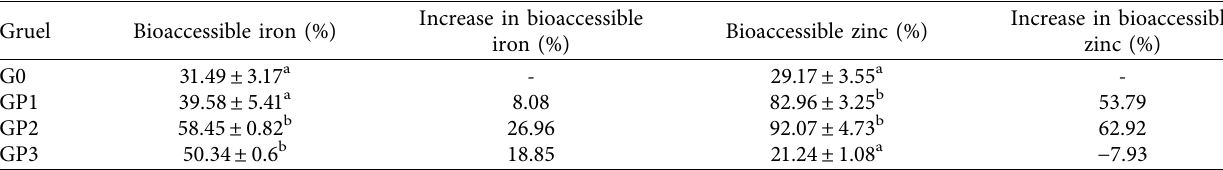
Table 5: Bioaccessibility of iron and